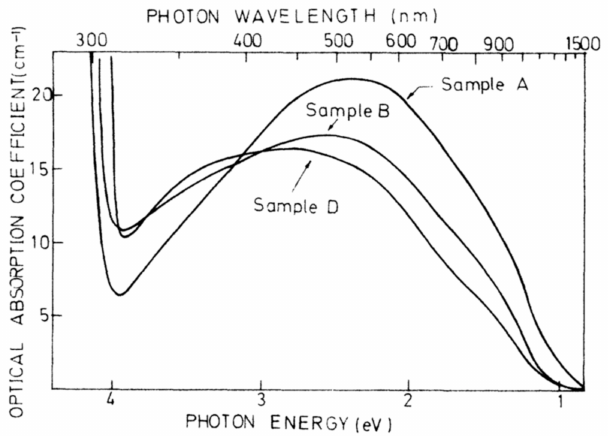
Figure 2. Optical absorption induced by 2 h 40 keV X-irradiation in LN samples with different bulk [Li]/[Nb] ratios derived a posteriori from measurements of the UV absorption edge (see Section 3.3). Sample A: 0.98 nearly stoichiometric, sample B: 0.96 nearly congruent, sample D: 0.92 sub-congruent, all irradiated and measured at 77 K. (Reprinted with the permission from Ref [49]. Copyright 2021 American Physical